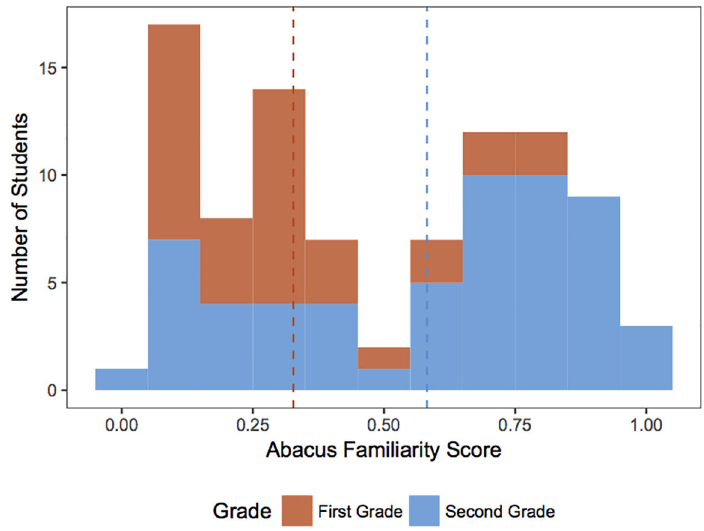
Figure 3. Histogram of abacus familiarity scores, broken down by grade. Dashed lines show